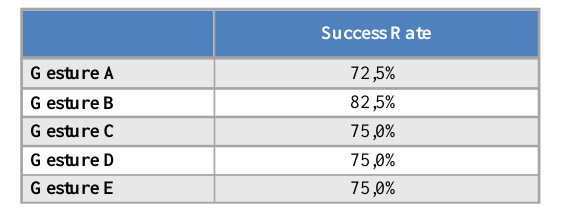
Table 1. Success rate for individual gesture recognition tests.